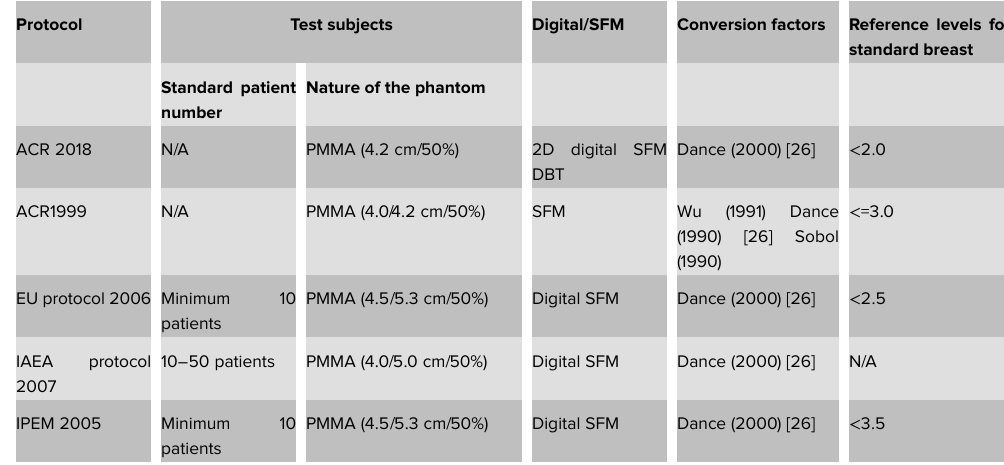
Table 3: Summary of the protocols related to reviewed